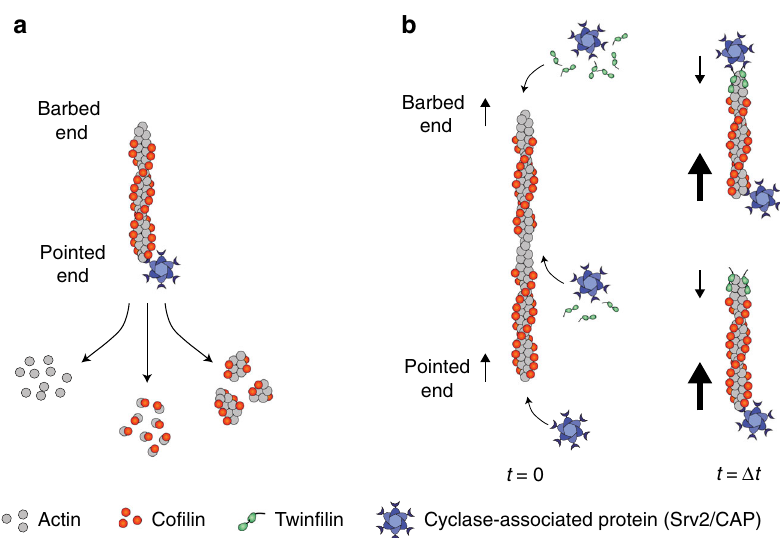
Fig. 5 Working model for Srv2/CAP, Co fi lin, and Twin fi lin functions in actin disassembly. a Srv2 hexamers bind transiently (for ~2 s on average) to the pointed ends of Co fi lin-saturated actin fi laments. In a subset of these binding events, Srv2 catalyzes the dissociation of actin subunits. Subunits might be released as actin monomers, Co fi lin-bound monomers, and/or Co fi lin-bound oligomers. b On fi laments that are more sparsely decorated with Co fi lin, Srv2/ CAP can bind to fi lament sides and enhance Co fi lin-mediated severing, in addition to accelerating pointed-end depolymerization of the severing products. Twin fi lin interacts with fi lament barbed ends to promote their depolymerization, where its interactions with Srv2/CAP increase its processivity. The thickness of arrows indicates relative rates of polymerization or depolymerization at the two ends of the fi